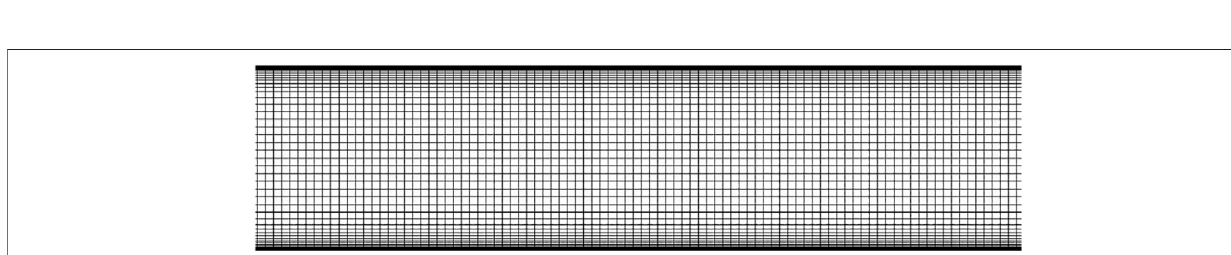
FIGURE 1 | Flow domains of fractures. (A) Smooth fracture; (B) rough fracture.